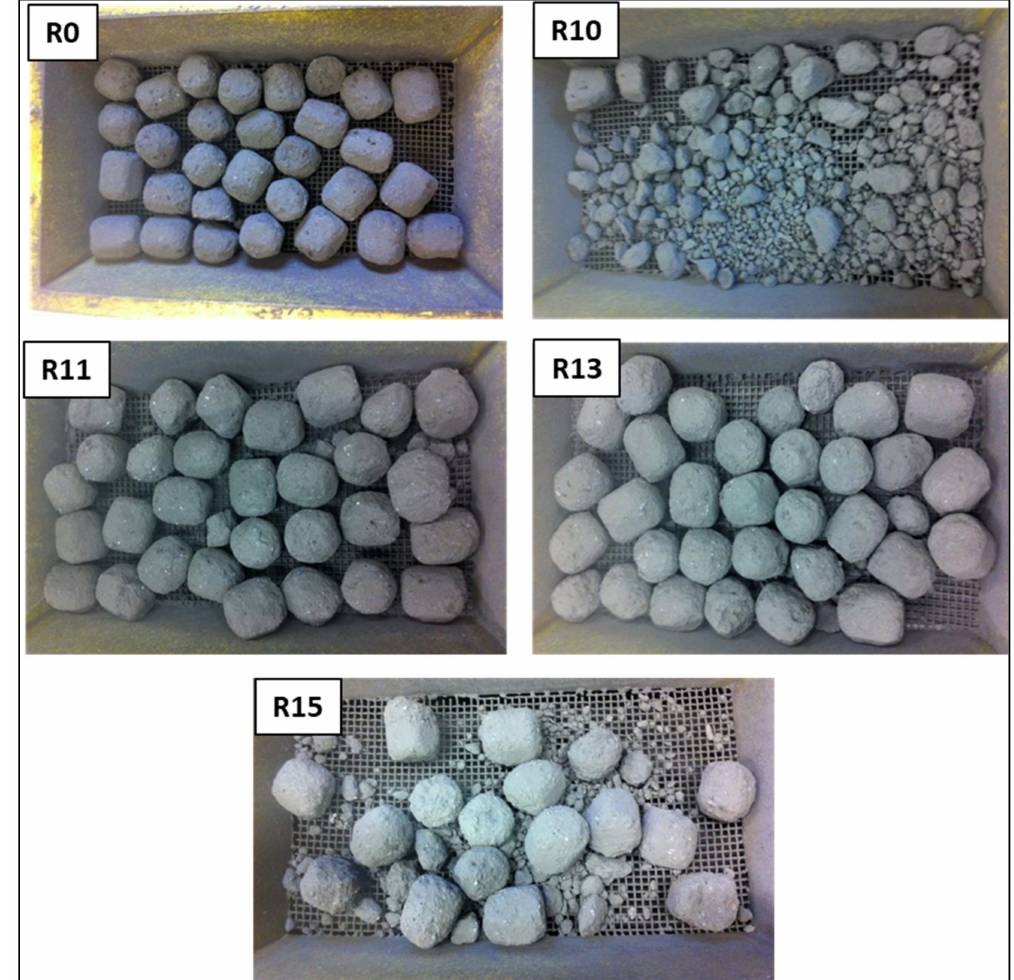
Figure 5. Briquettes after tumbler